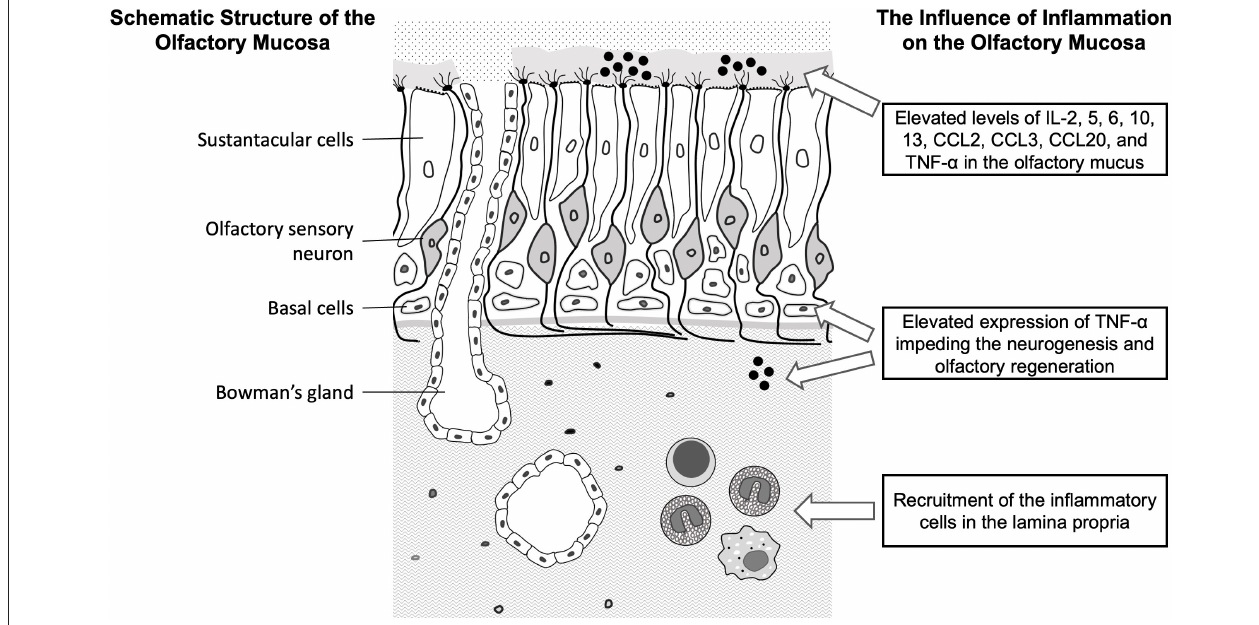
FIGURE 1 | The illustration of the structure of the olfactory mucosa and the known inflammatory mechanisms leading to olfactory dysfunction. IL, interleukin; CCL, C-C motif chemokine ligand; TNF, tumor necrosis factor. Sustentacular cells enwrap olfactory sensory neurons to maintain the integrity and function of OSNs. Basal cells are located along the basement membrane and capable of replenishing OSNs to maintain ongoing neurogenesis during adult